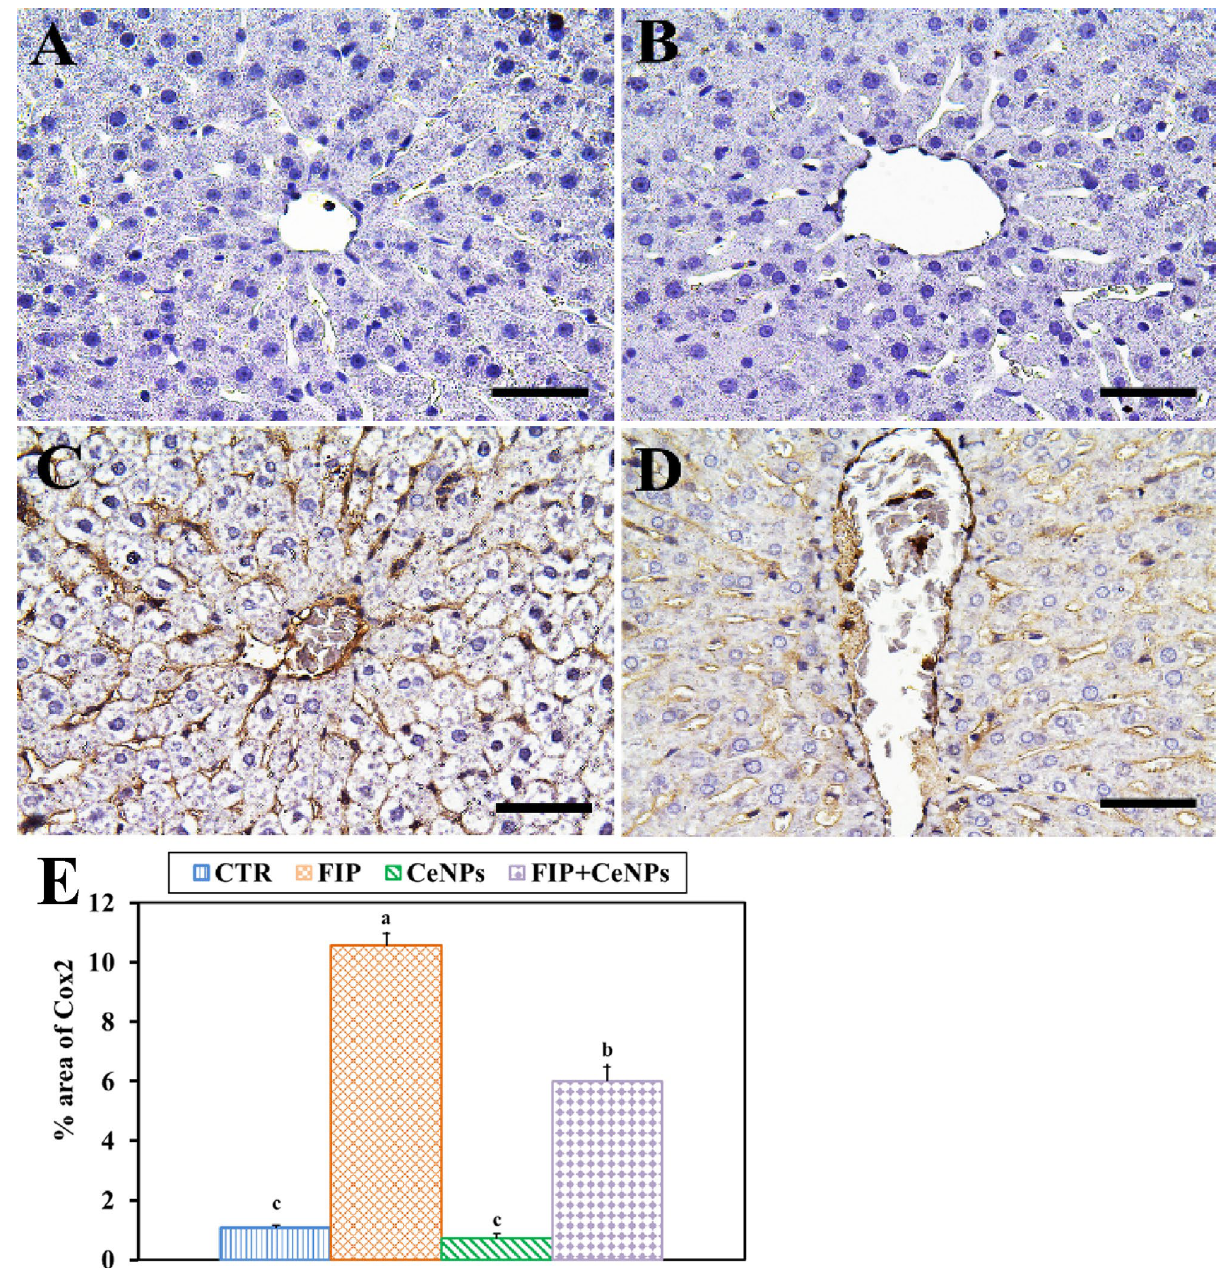
Figure 6. Immunohistochemical staining of rat liver by COX-2. ( A ) negative control group. ( B ) CeNPs group. ( C ) FIP group. ( D ) FIP group that treated with CeNPs. Scale bar = 50 µm. ( E ) Quantification of COX-2 in the hepatic tissues in different groups. Data expressed as Mean ± SE, analyzed using one-way ANOVA at P ≤ 0.05, column with different letters (a, b & c) indicate significant difference among the values of different groups.